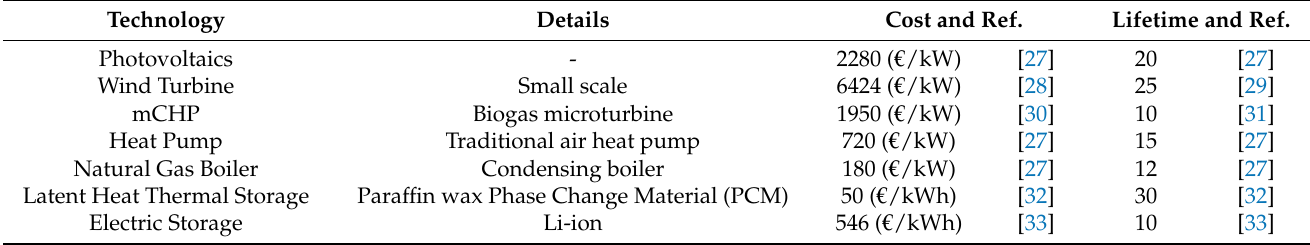
Table 3. RES investment